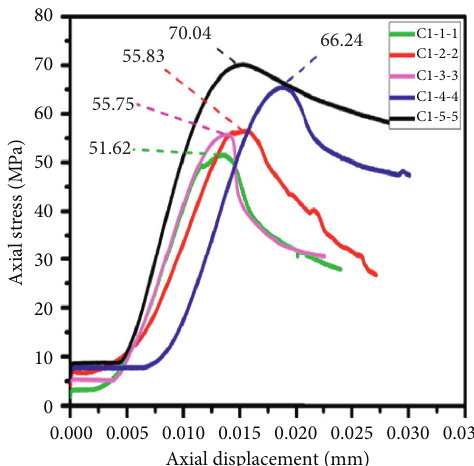
Figure 15: Axial displacement-axial stress curve of group C1.